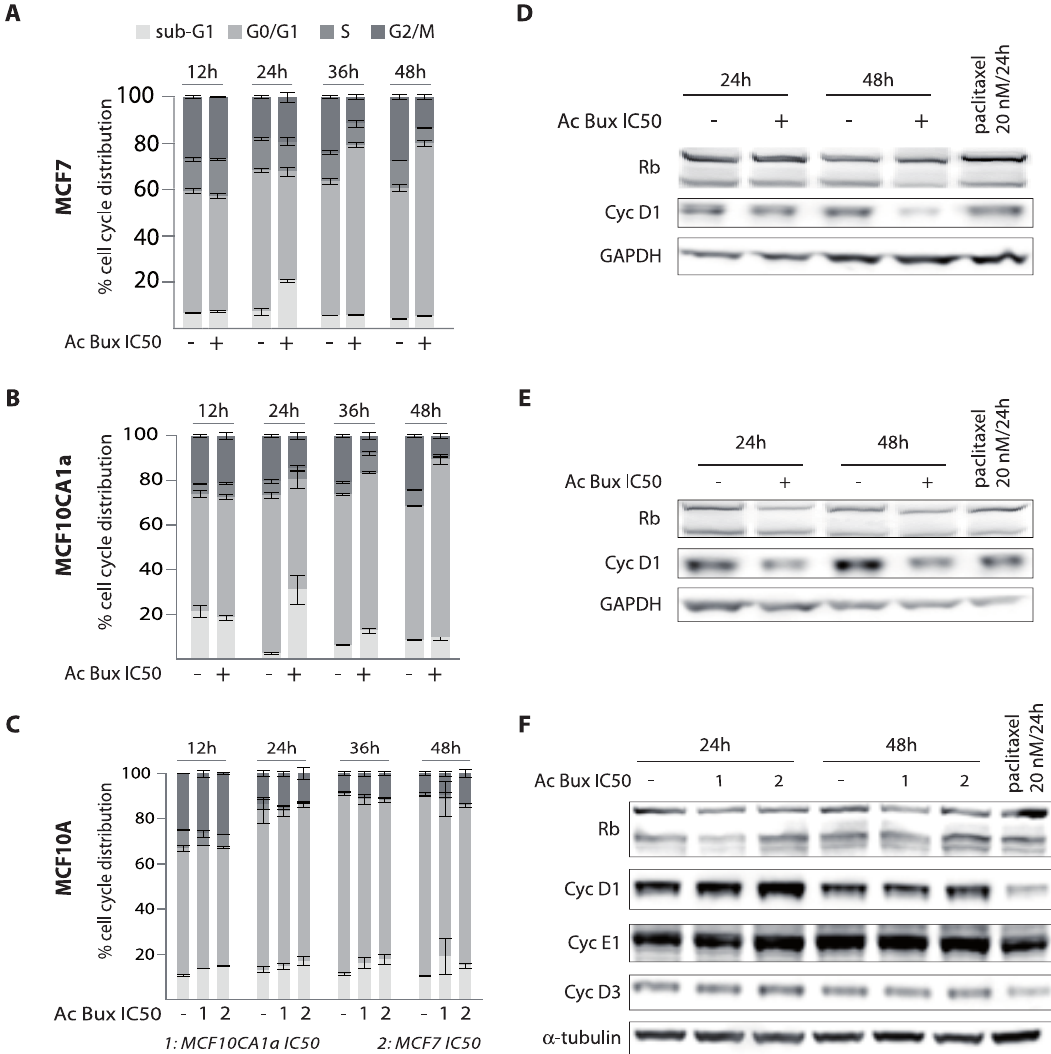
Figure 2. The acetonic extract of Buxus induces cell cycle arrest in MCF7 and MCF10CA1a breast cancer cell lines. A. MCF7 cells were incubated for increasing period intervals (12 h, 24 h, 36 h and 48 h) with their IC 50 concentrations. The results represent means 6 SEM of three experiments. B. MCF10CA1a cells were incubated for increasing period intervals (12 h, 24 h, 36 h and 48 h) with their IC 50 concentration. The results represent means 6 SEM of three experiments. C. MCF10A cells were incubated for the same period intervals (12 h, 24 h, 36 h and 48 h) with the IC 50 of MCF7 and MCF10CA1a, respectively. The results represent means 6 SEM of three independent experiments. D. Immunoblots of total cell extracts isolated from MCF7 treated or not with plant extract as indicated and probed with an anti-cyclin D1 antibody. GAPDH was used as a loading control. E. Immunoblots of total cell extracts isolated from MCF10CA1a treated or not with plant extract as indicated and probed with an anti-cyclin D1 antibody. GAPDH was used as a loading control. F. Immunoblots of total cell extracts isolated from MCF10A treated or not with plant extract (IC50s of MCF7 and MCF10CA1a concentrations) as indicated and probed with an anti-cyclin D1 antibody. a -tubulin was used as a loading control. Ac Bux: acetonic Buxus